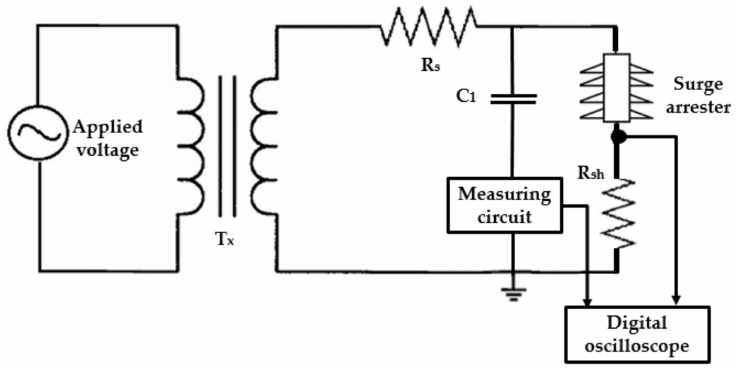
Figure 1. Experimental setup for leakage current measurement.